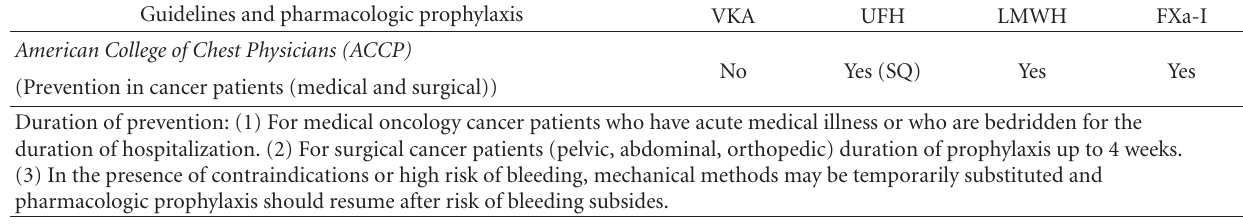
Table 1: Summary of guidelines for prevention and treatment of venous thromboembolism in cancer [5–8]. Guidelines and pharmacologic